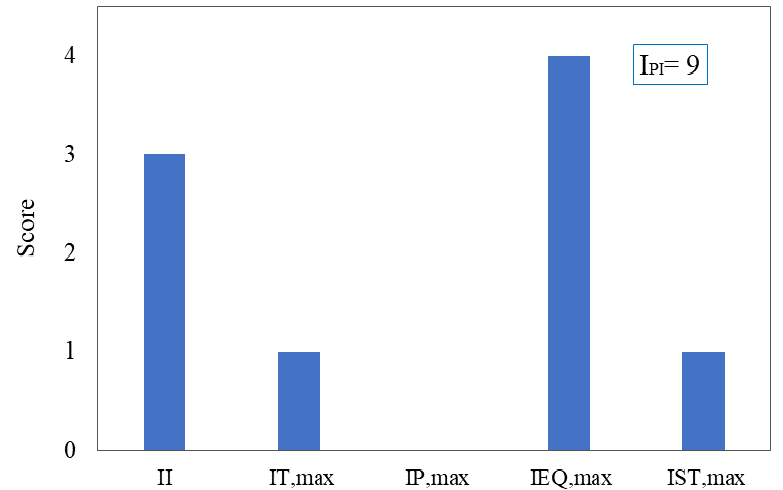
Figure 3. Calculated subindices for process inherent safety index and total score.